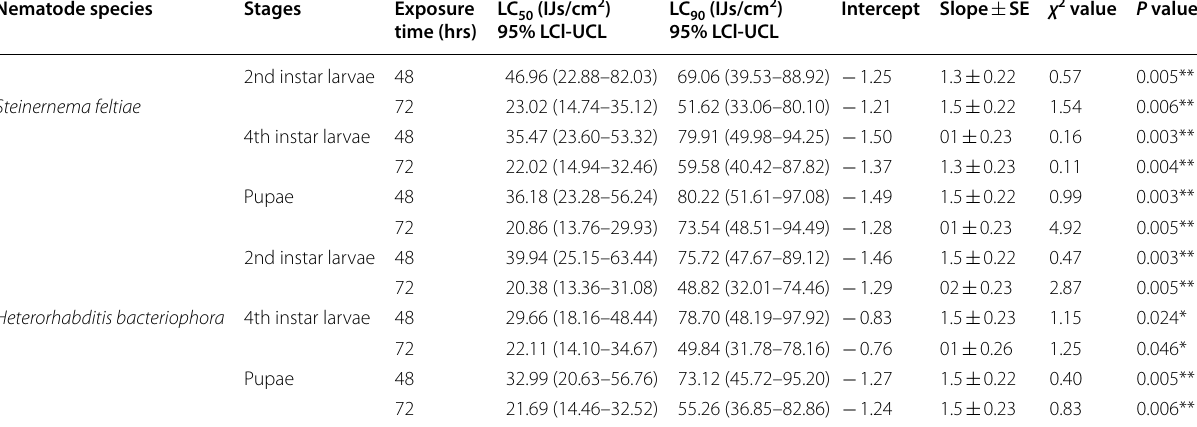
EPNs suspensions were administered at a concentration of (IJs/cm 2 ) Lethal Concentrations are calculated by Probit Methods